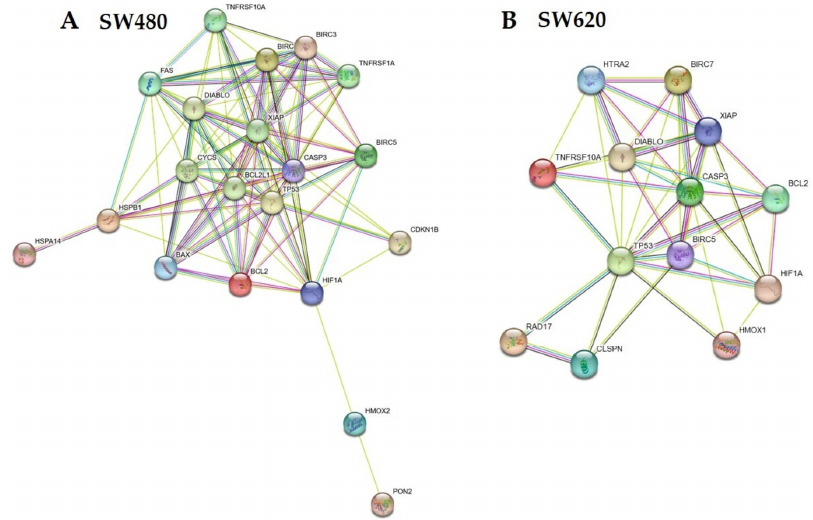
Figure 6. Representative network of LMPE-modulated proteins predicted by STRING ® for cell lines SW480 ( A ) and SW620 ( B ). Table 1. Biological processes and KEGG pathways after the STRING ® analysis of LMPE-modulated proteins for SW480 and SW620 cells. Analysis of protein interactions.